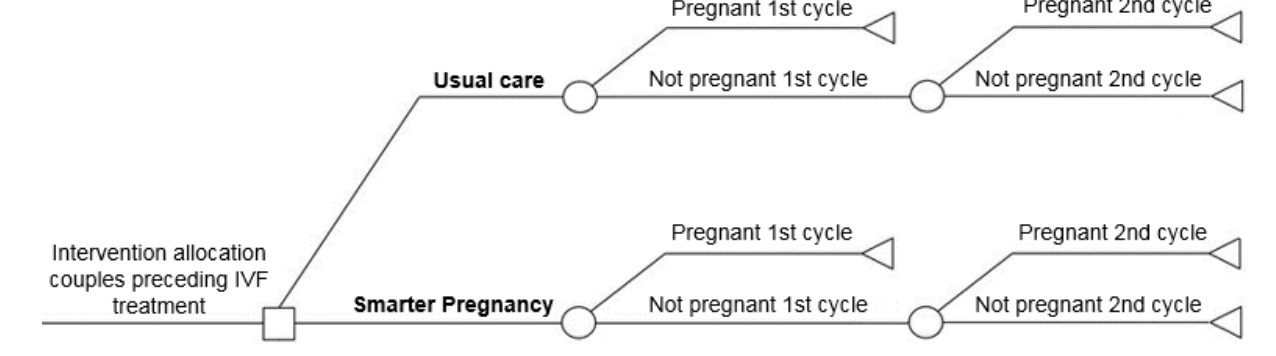
Figure 2. Decision tree model. IVF: in vitro